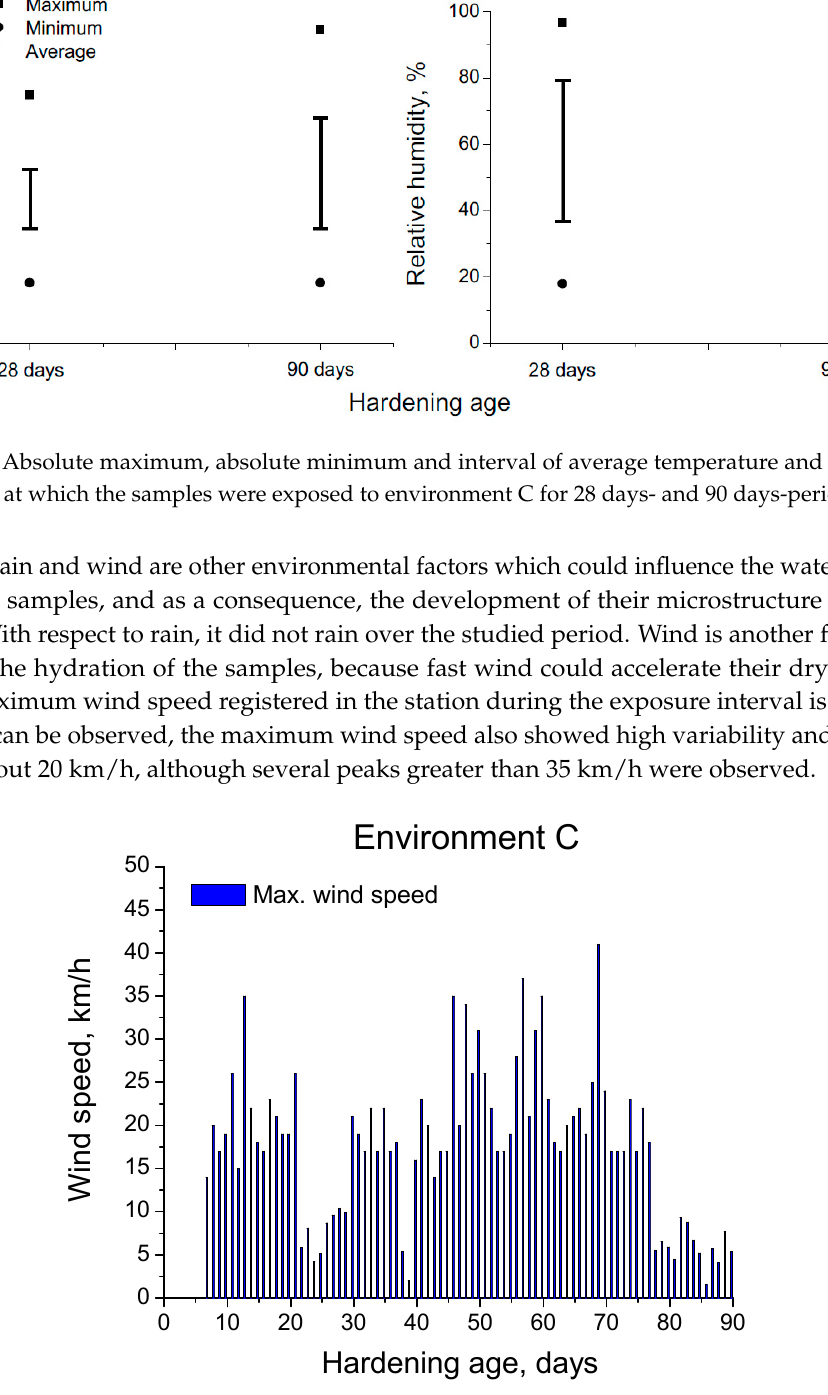
Figure 6. Daily maximum wind speed registered in the station over the exposure period to environment C.